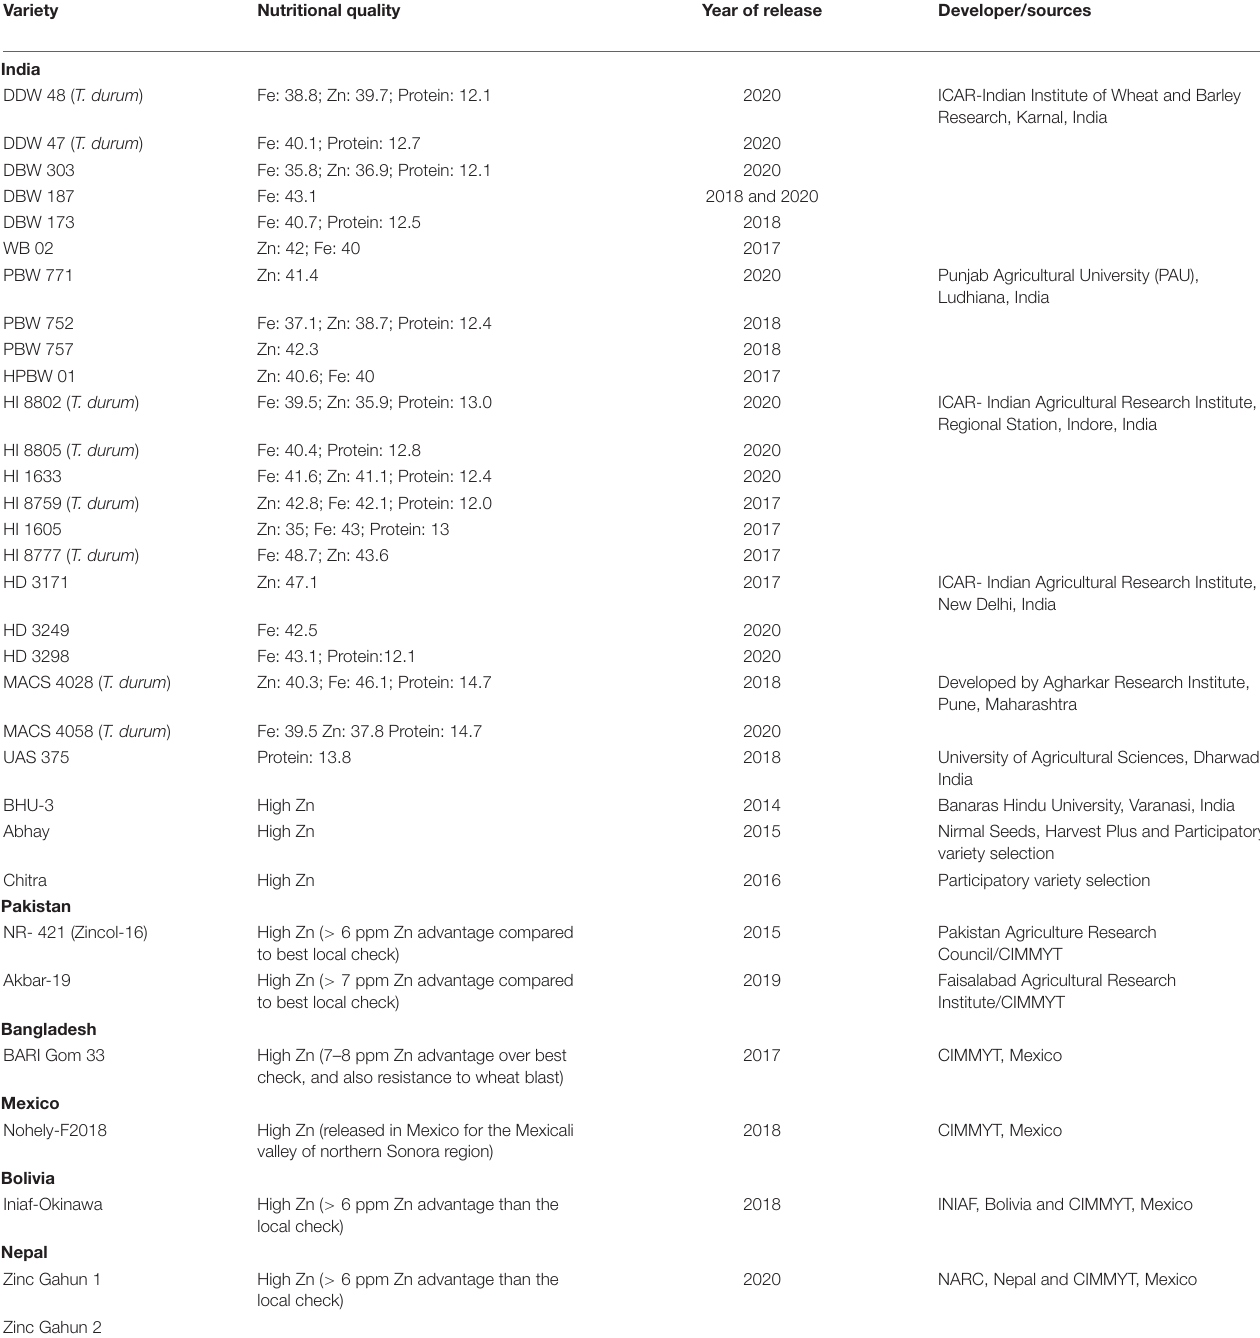
TABLE 2 | List of biofortified wheat varieties developed through conventional breeding and released for commercial cultivation around the globe.